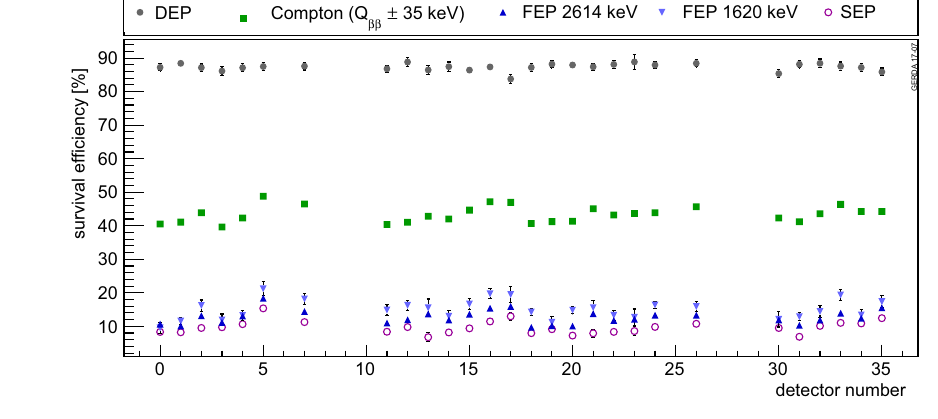
Fig. 23 Survival efficiencies for the double escape (DEP) and single escape peak (SEP) of the 2615keV γ line of 208 Tl, for the full energy γ peaks (FEPs) at 1620keV and 2615keV, and the Compton events around Q ββ [37]. Uncertainties are partly smaller than the symbols